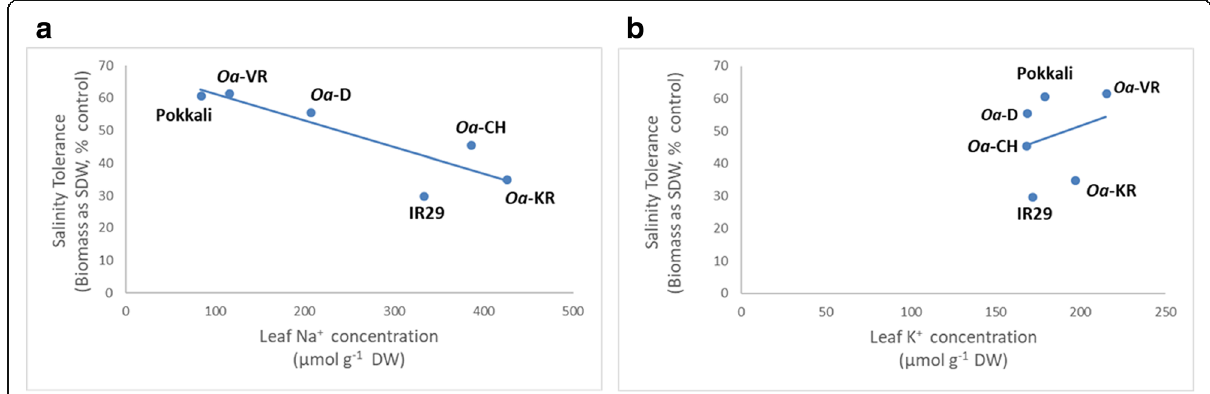
Fig. 2 Linear regression of Salinity Tolerance (ST) against: a leaf Na + concentrations [ μ mol Na + g -1 (SDW)] (R 2 = 0.75) and b leaf K + concentrations [ μ mol Na + g -1 (SDW)] (R 2 = 0.69). ST was calculated as the percentage ratio of mean shoot dry weight (salt treatment, 80 mM of NaCl) divided by mean shoot dry weight (control, no salt) [SDW (salt treatment))/(SDW (control)) x